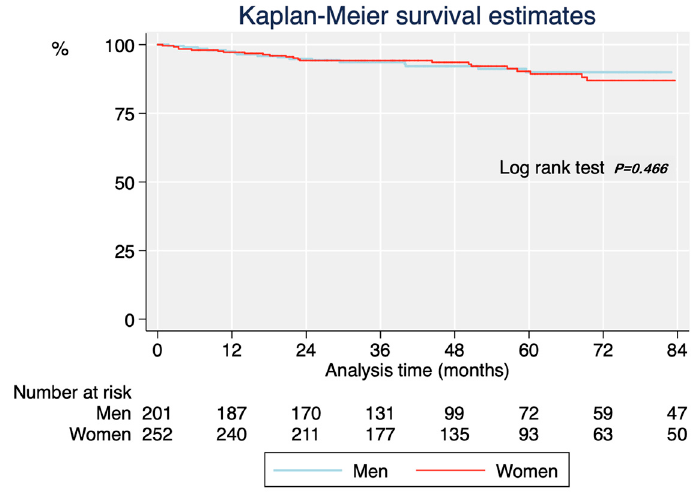
Figure 5. Crude Kaplan-Meier survival curves by sex.